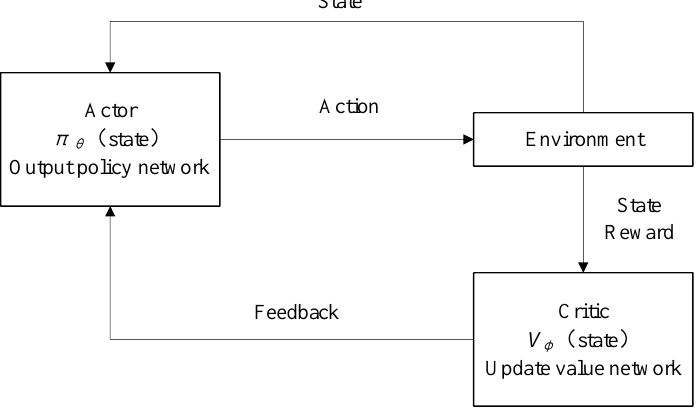
Figure 3. A typical actor – critic structure of PPO.